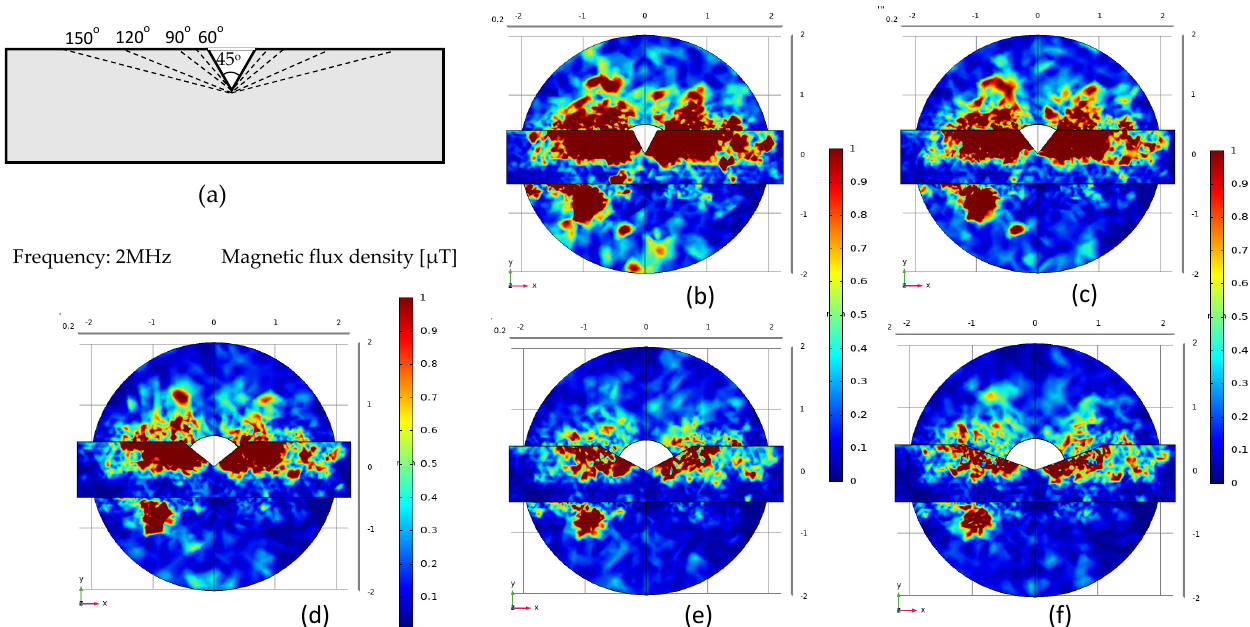
Figure 3. Comparison of simulation results of permalloy triangle notches: ( a ) Different permalloy structures; ( b – f ) Simulation results.